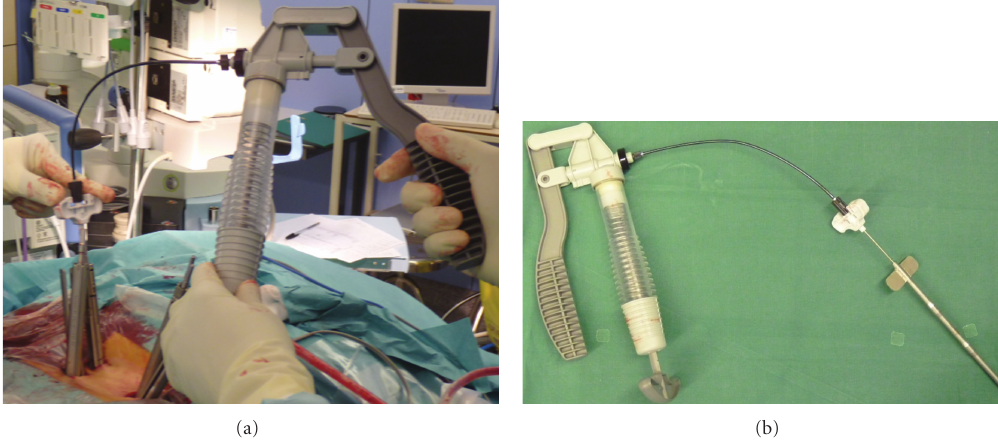
Figure 5: The screw and the cement delivery system are connected using a specifically designed connector. The PMMA bone cement is delivered through the cement cannula placed within the cannulation of the fenestrated screws under continuous image intensifier